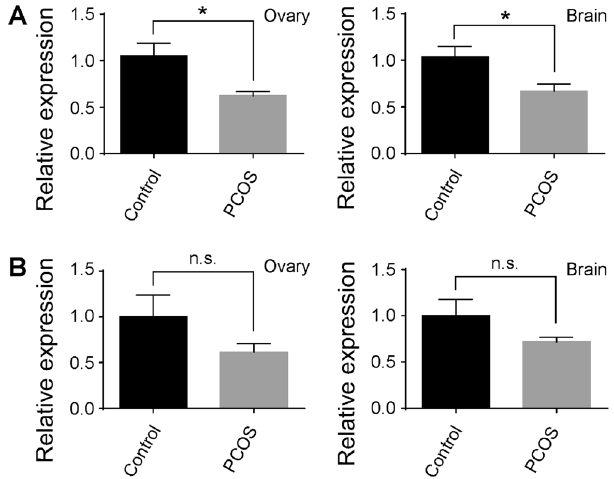
Figure 3. The expression of Tox3 ( A ) and Dennd1a ( B ) in isolated ovary and brain tissues from the control (black bars) and PCOS (grey bars) animals. The expression of Tox3 and Dennd1a in the control sample was normalized to 1, and their expression in PCOS fish was compared to the base value of 1. Note the decrease of Tox3 expression in PCOS samples. However, no significant changes in Dennd1a expression were detected. Data represents the means ± SE (n = 8 in each group). *p < 0.05; ns not significant.